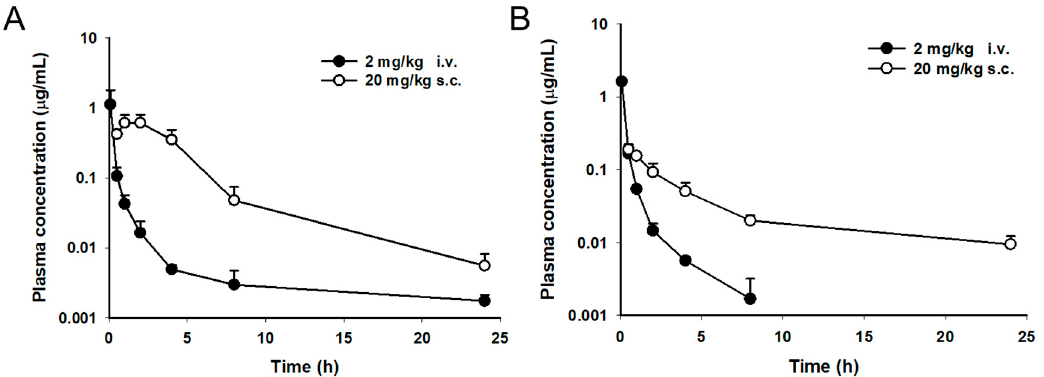
Figure 3. Plasma concentration ‐ time profiles for coralmycin A ( A ) and DH ‐ coralmycin A ( B ) in mice after intravenous (i.v.) and subcutaneous (s.c.) administration. The data were examined after i.v. ( ● ) and s.c. ( ○ ) injection (mean ± SD, n = 3). Table 2. Pharmacokinetic parameters of coralmycin A and DH ‐ coralmycin A after i.v. and s.c. ad ‐ ministration (mean ± SD, n = 3).